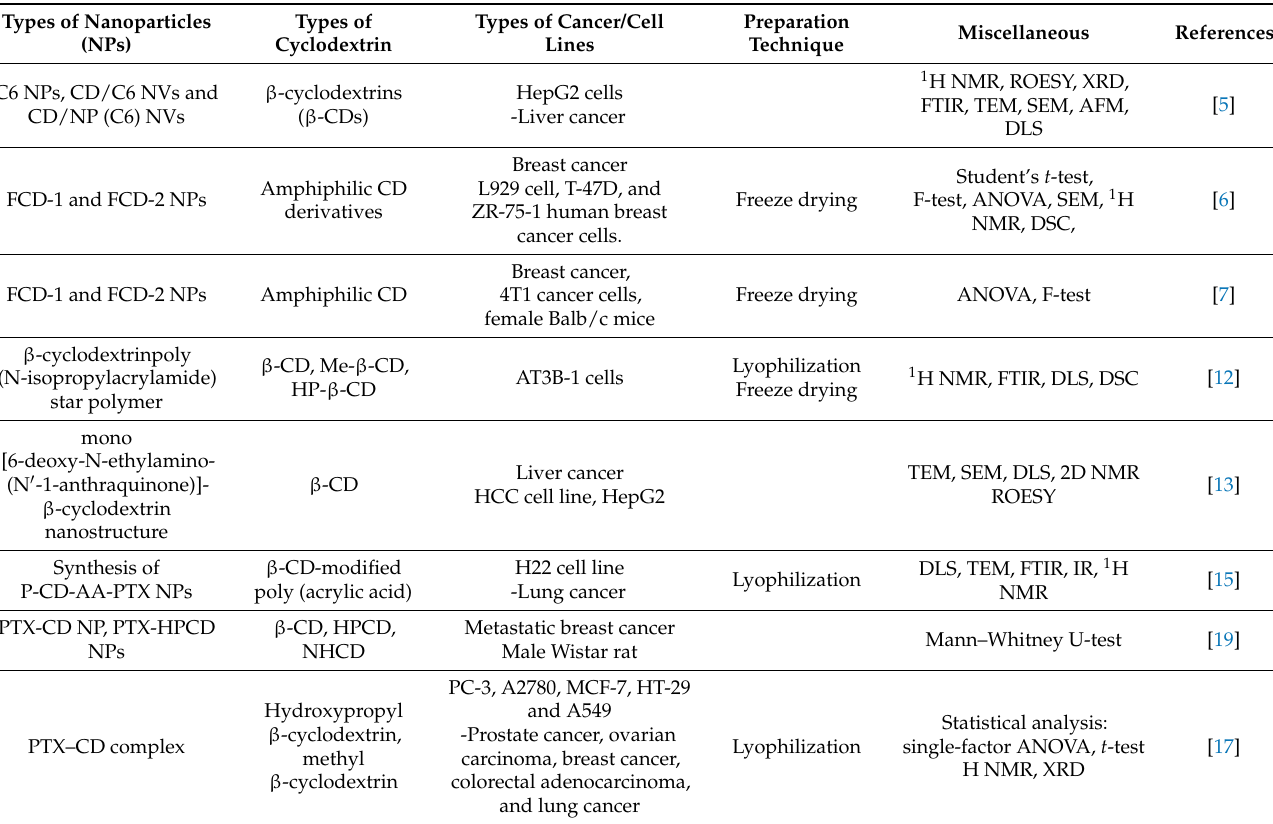
Table 2. Details of application of cyclodextrin paclitaxel nanoparticles, with a focus on type of nanoparticles, cyclodextrin type, preparation technique and type of cancer